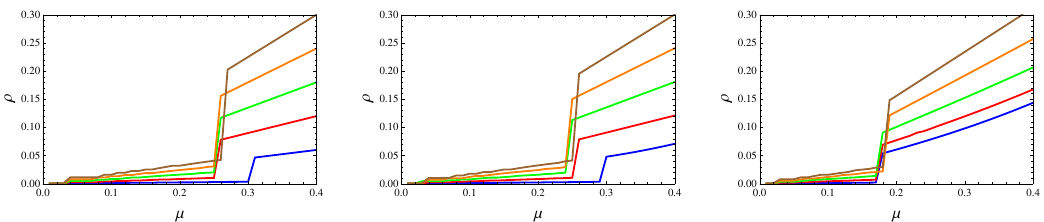
Figure 11 . The charge density (cid:26) as a function of the chemical potential (cid:22) for (cid:12)ve di(cid:11)erent values of the magnetic (cid:12)eld b = 0 : 05 (blue), b = 0 : 1 (red), b = 0 : 15 (green), b = 0 : 2 (orange) and b = 0 : 25 (brown). The left, center and right panels correspond to v T = 0, v T = 0 : 1 and v T = 0 : 3,